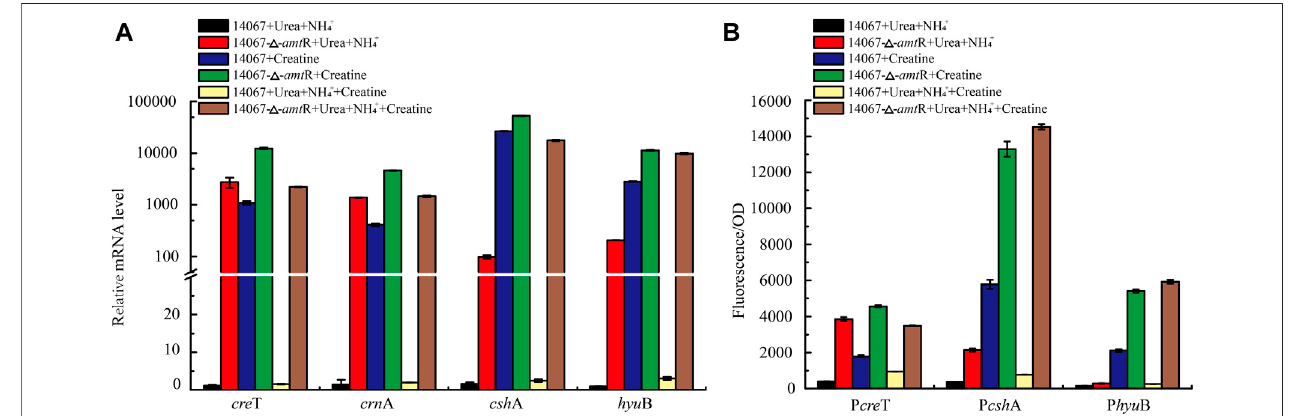
FIGURE 5 | AmtR regulates creatine degradation in C. glutamicum ATCC 14067. (A) Relative expression of cre T, crn A, csh A, and hyu B of C. glutamicum ATCC 14067wild-typeand Δ amt RstrainsgrowninCGXIImediumwithcreatineorammoniumandureaasnitrogensources. (B) Promoteractivityof cre T, csh A,and hyu Bof C. glutamicum ATCC 14067 wild-type and Δ amt R strains grown in CGXII medium with creatine or ammonium and urea as nitrogen